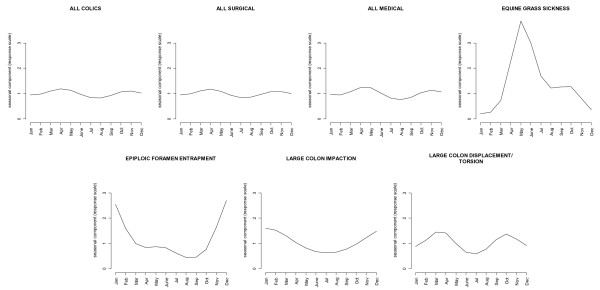
Estimate of model's seasonal component for each colic type. For each colic type an estimate of the model's seasonal component was extracted using the posterior mean of the parameter associated with each of the sine and cosine terms based on the frequencies detected for each group in Table 2. With the exception of the large colon impaction group (12 month cycles only) all models incorporated 12- and 6-monthly cycles.